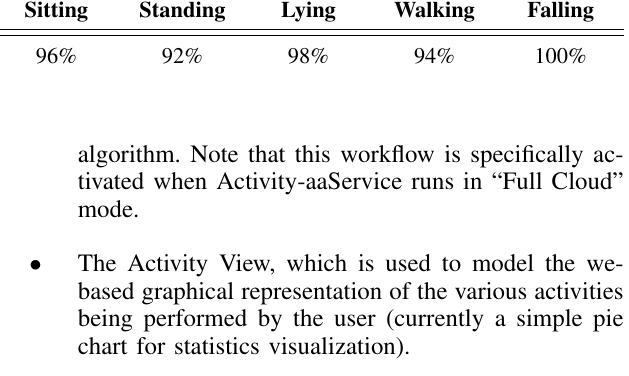
P OSTURE /M OVEMENT RECOGNITION ACCURACY . Sitting Standing Lying Walking Falling 96% 92% 98% 94%